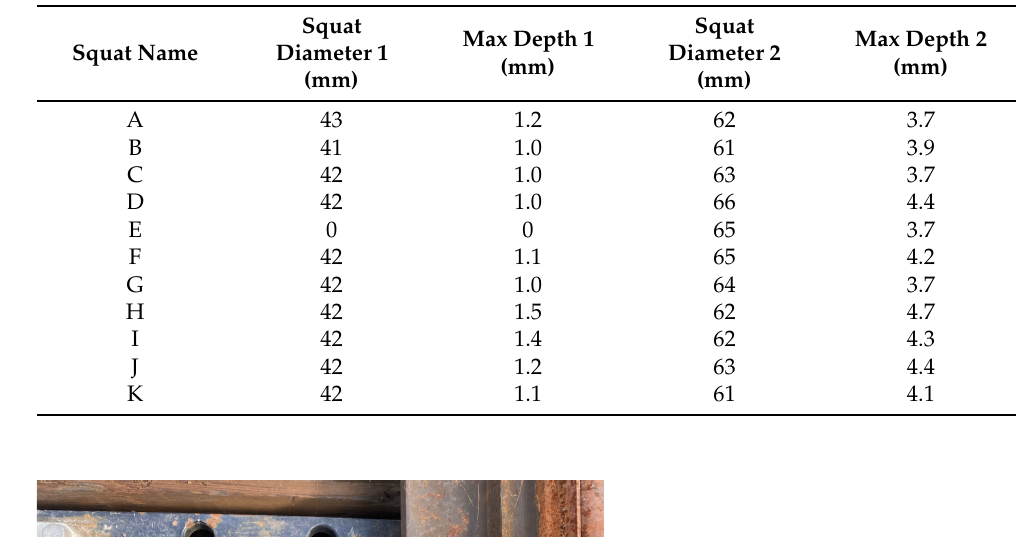
Table 1. Dimension measurements of the two squat levels.